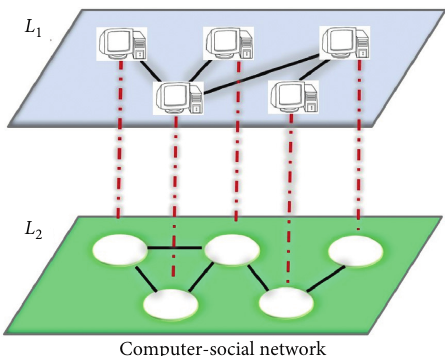
Figure 1: Illustration of computer-social networks. Subnetwork L represents the computer network, and subnetwork L social